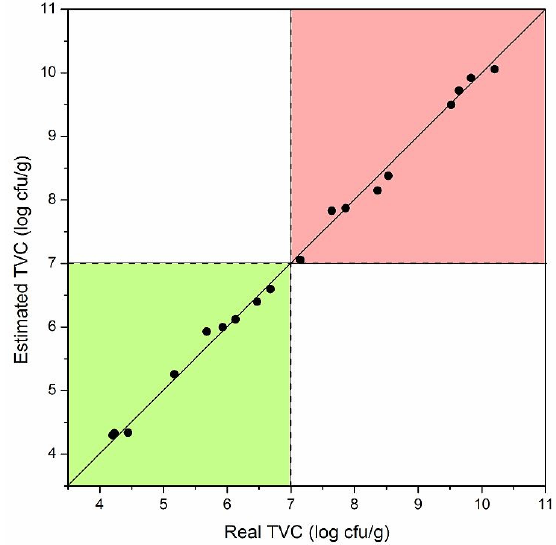
Figure 8. Estimates of the TVC values versus the actual measured TVC values for random rainbow trout samples. The green color indicates the area in which the microbial load was compatible with consumption while the red one indicates that the fish had deteriorated.